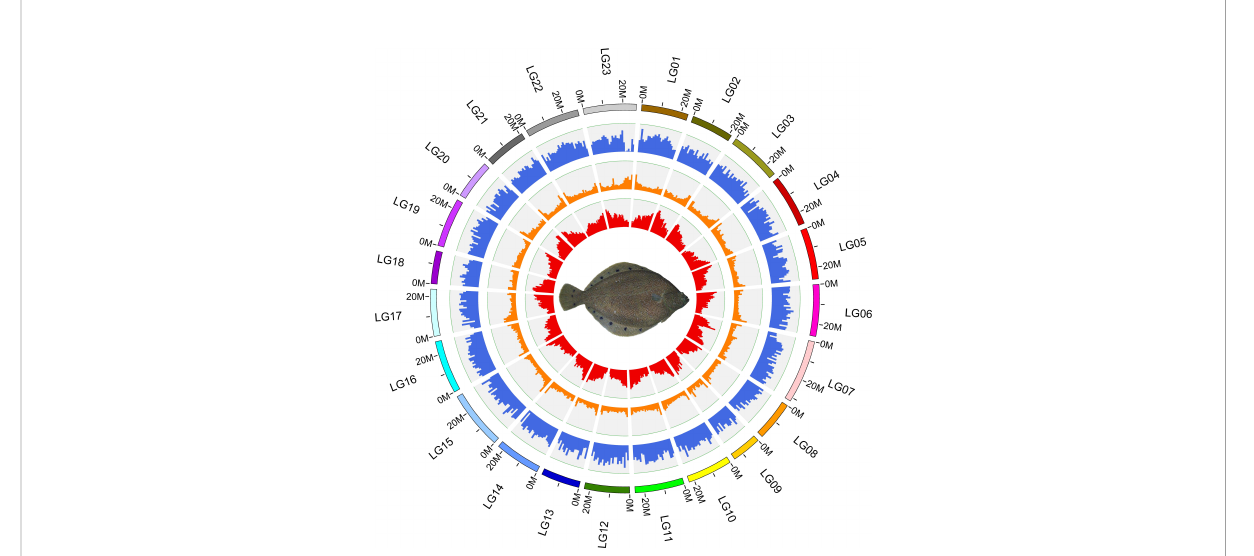
FIGURE 2 Circos plot basic characteristics of the reference genome of Verasper variegatus , from outside to inside circles indicate: the gene density, repeat content, GC